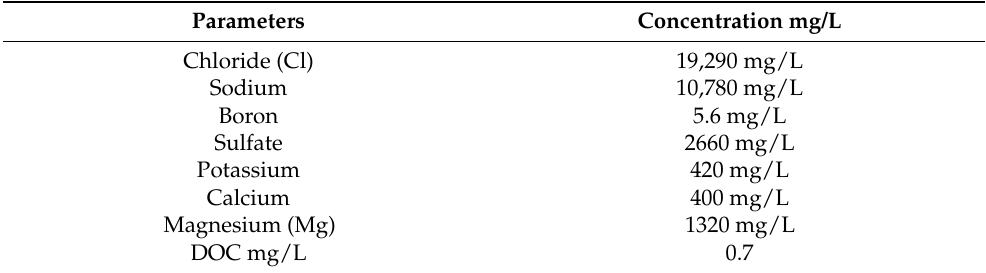
Table 2. Water quality of synthetic seawater used in this